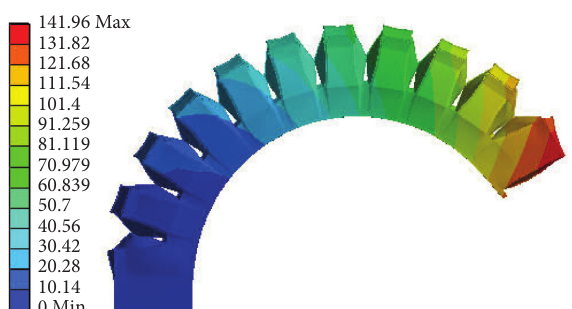
Figure 2: Numerical simulation calculation results of pneumatic soft-bodied bionic basic execution unit. The inflation pressure is constant at 180 kpa. Table 2: Level and coding of test factors in response surface.